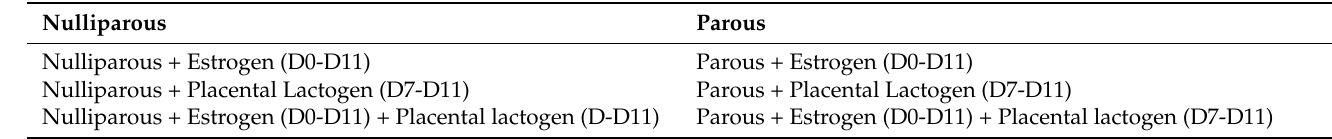
Table 1. Treatment Groups. Experimental design and nomenclature of in vivo treatment groups. Nulliparous and parous female mice were subdivided into 8 different groups comprised and received either a slow-release estrogen tablet implantation, placental lactogen injections, or both. Control animals underwent sham surgery and/or PBS injections. Nomenclature describes the treatments and treatment days used in in vivo pseudopregnancy model and subsequent